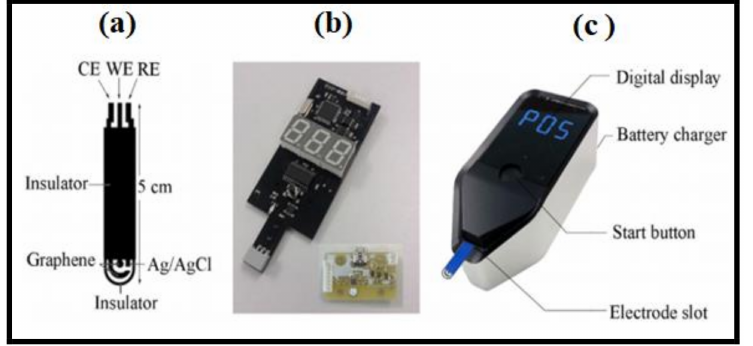
Figure 7. Portable mini-potentiostat ( a ) comprising a screen-printed graphene electrode, working electrode, and reference electrode; ( b ) photograph of a printed circuit board; ( c ) outer view of the portable mini-potentiostat, reproduced with permission from [53] (Jantana Kampeera et al.,